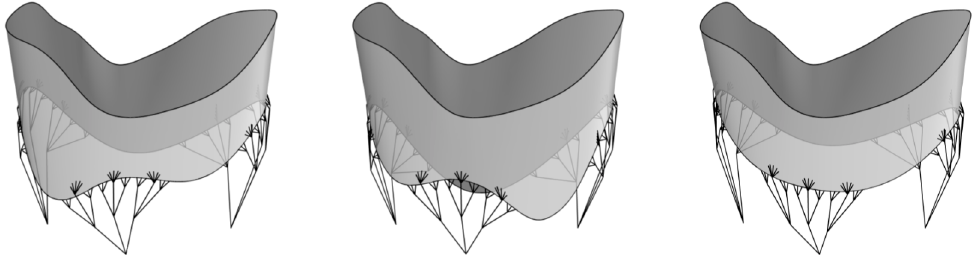
Figure 15. TV geometries with varying leaflet and commissure heights.